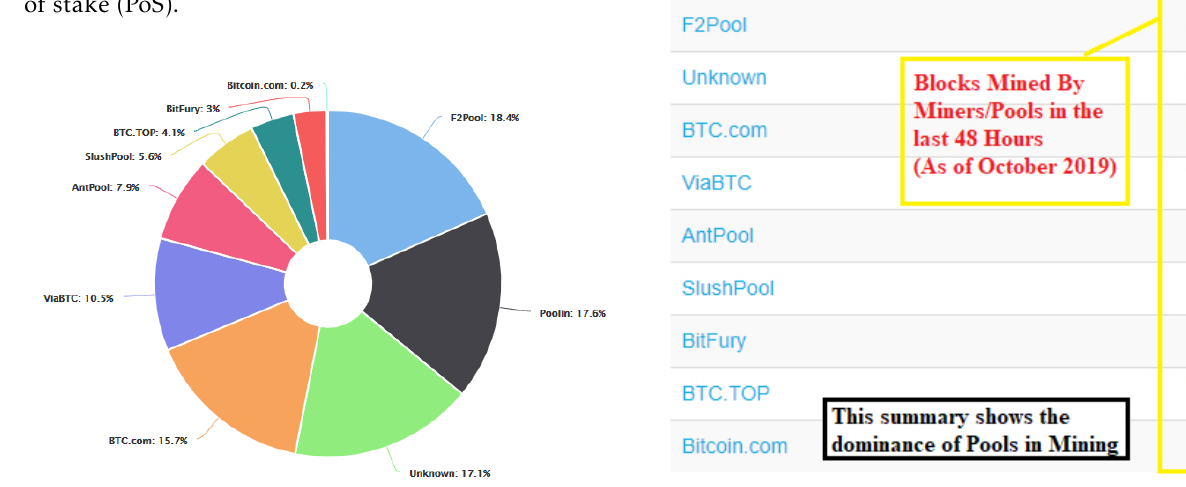
Figure 5. Hashrate Distribution of 2019 (October), Source: Blockchain.com/pools